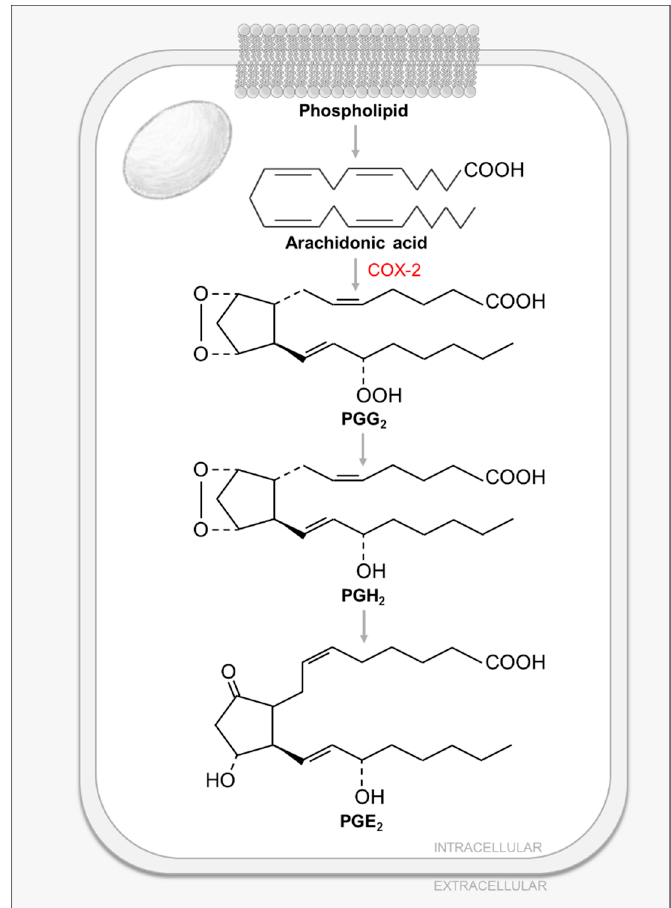
Figure 4. Prostaglandin Biosynthesis.